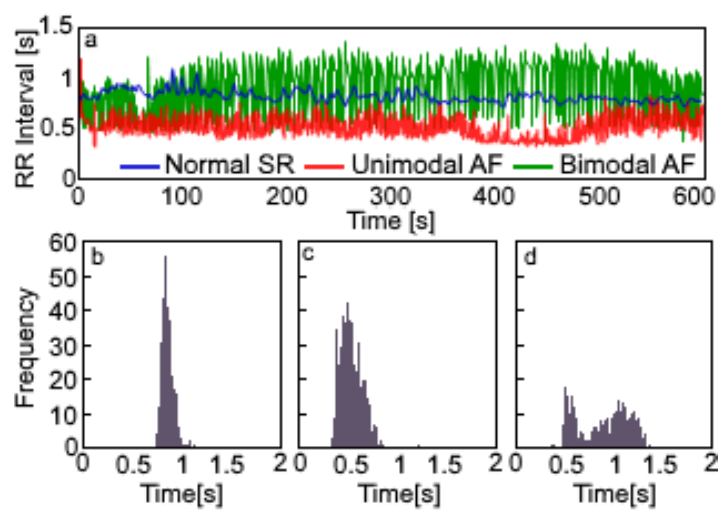
Figure 1. ( a ) The RR intervals used in simulations to simulate normal sinus rhythm (SR) and atrial fibrillation (AF) with unimodal and bimodal sample distributions, the frequency diagrams of RR intervals used to simulate ( b ) normal sinus rhythm, ( c ) atrial fibrillation with unimodal RR interval distribution and ( d ) atrial fibrillation with bimodal RR interval distribution. Time bin is 5 ms in the frequency histograms.